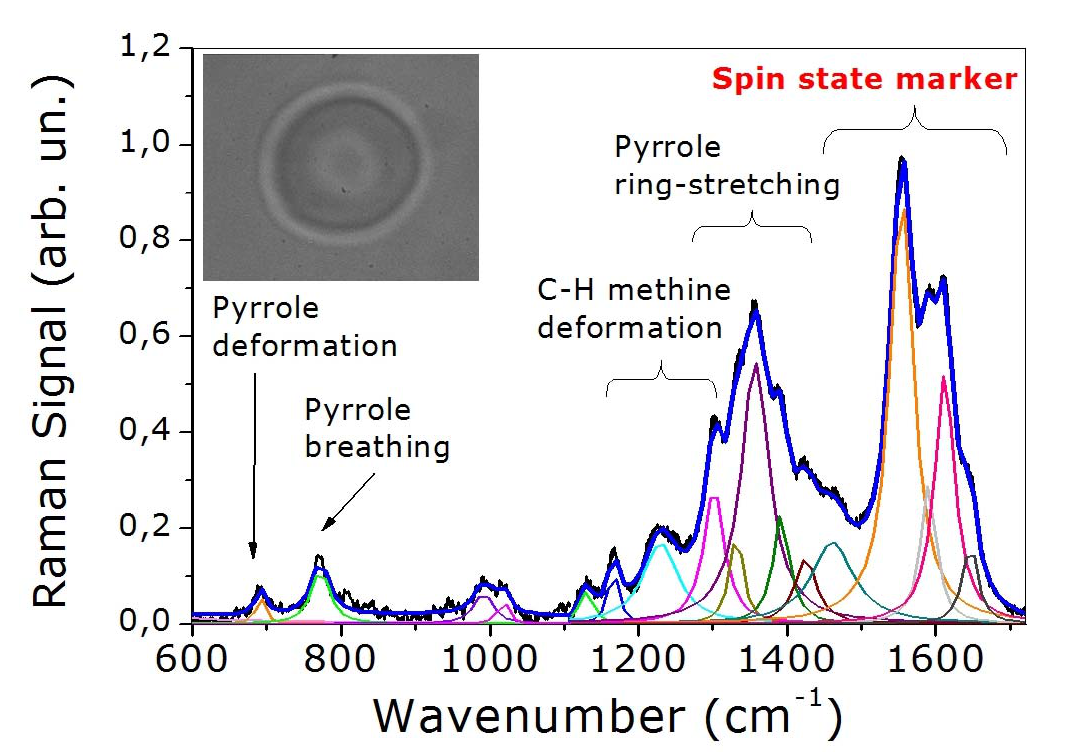
Figure 3. Resonant Raman spectrum of a healthy optically trapped RBC. In the inset we show the image of a trapped